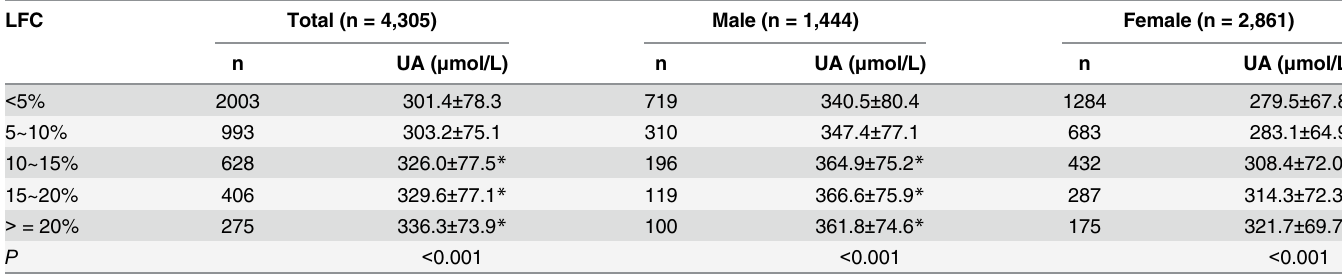
Table 4. Levels of serum uric acid with increases in